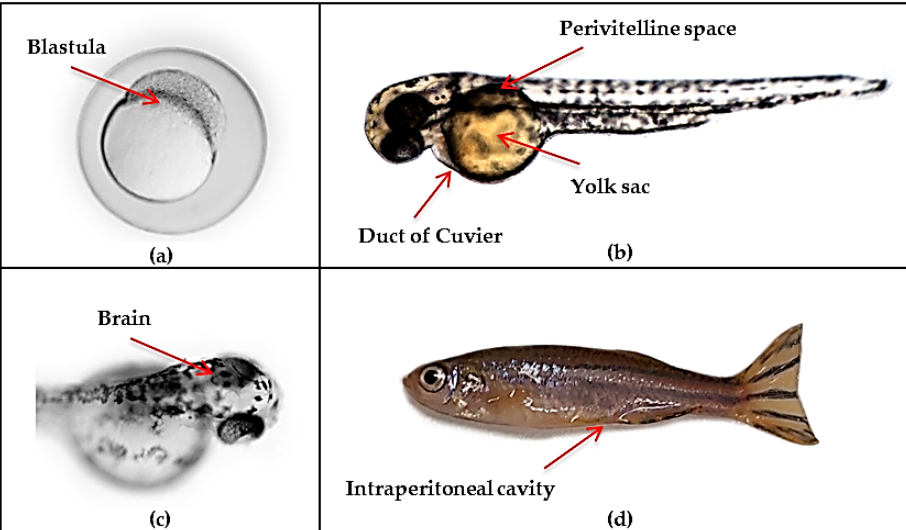
Figure 3. Injection sites commonly used in zebrafish xenotransplantation assays: ( a ) Blastula (3.5 hpf); ( b ) Duct of Cuvier, perivitelline space and yolk sac in zebrafish embryo (48 hpf); ( c ) Embryo brain (48 hpf); ( d ) Intraperitoneal cavity in adult zebrafish. Images ( a – c ) were acquired in our lab with a stereomicroscope (AZ-100 Multizoom, Nikon). Image ( d ) was acquired in our lab with a Samsung Galaxy A70.